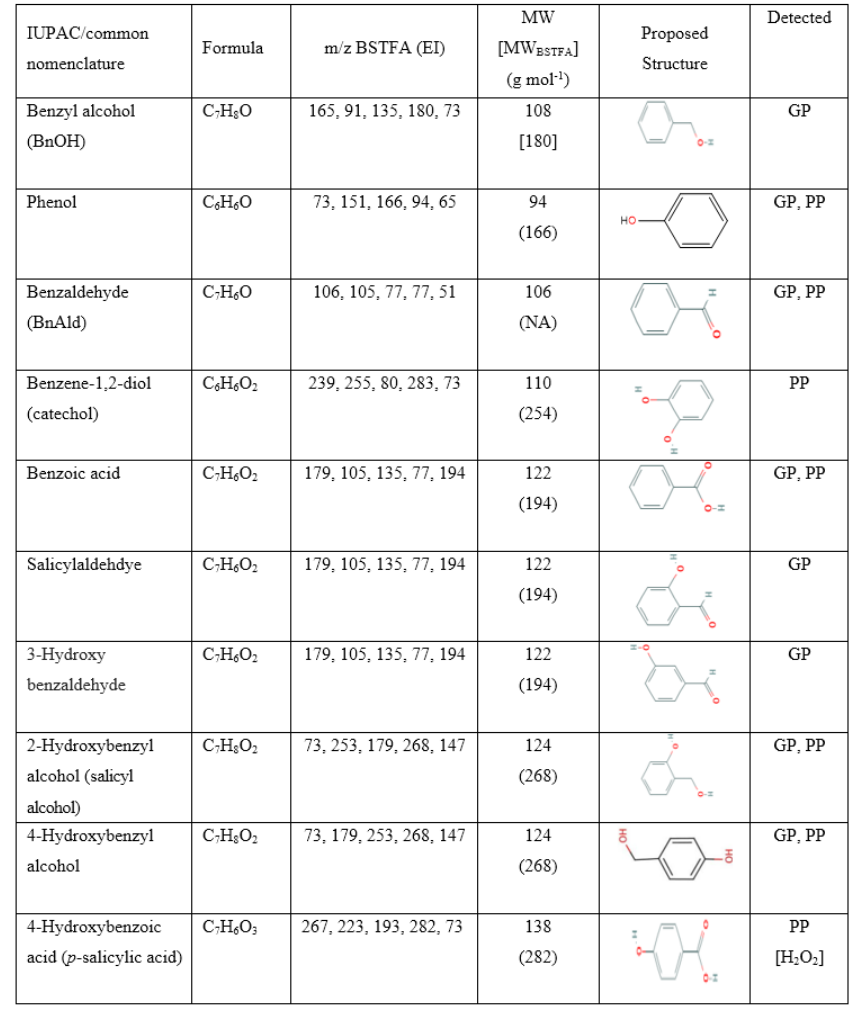
Table 5. Summary of selected reaction products detected and identified in either the gas phase (GP), particle phase (PP), or both from BnOH / NO x and BnOH / H 2 O 2 experiments. Tables 6 and 7 show additional aerosol species with a high oxygen-to-carbon ratio and/or